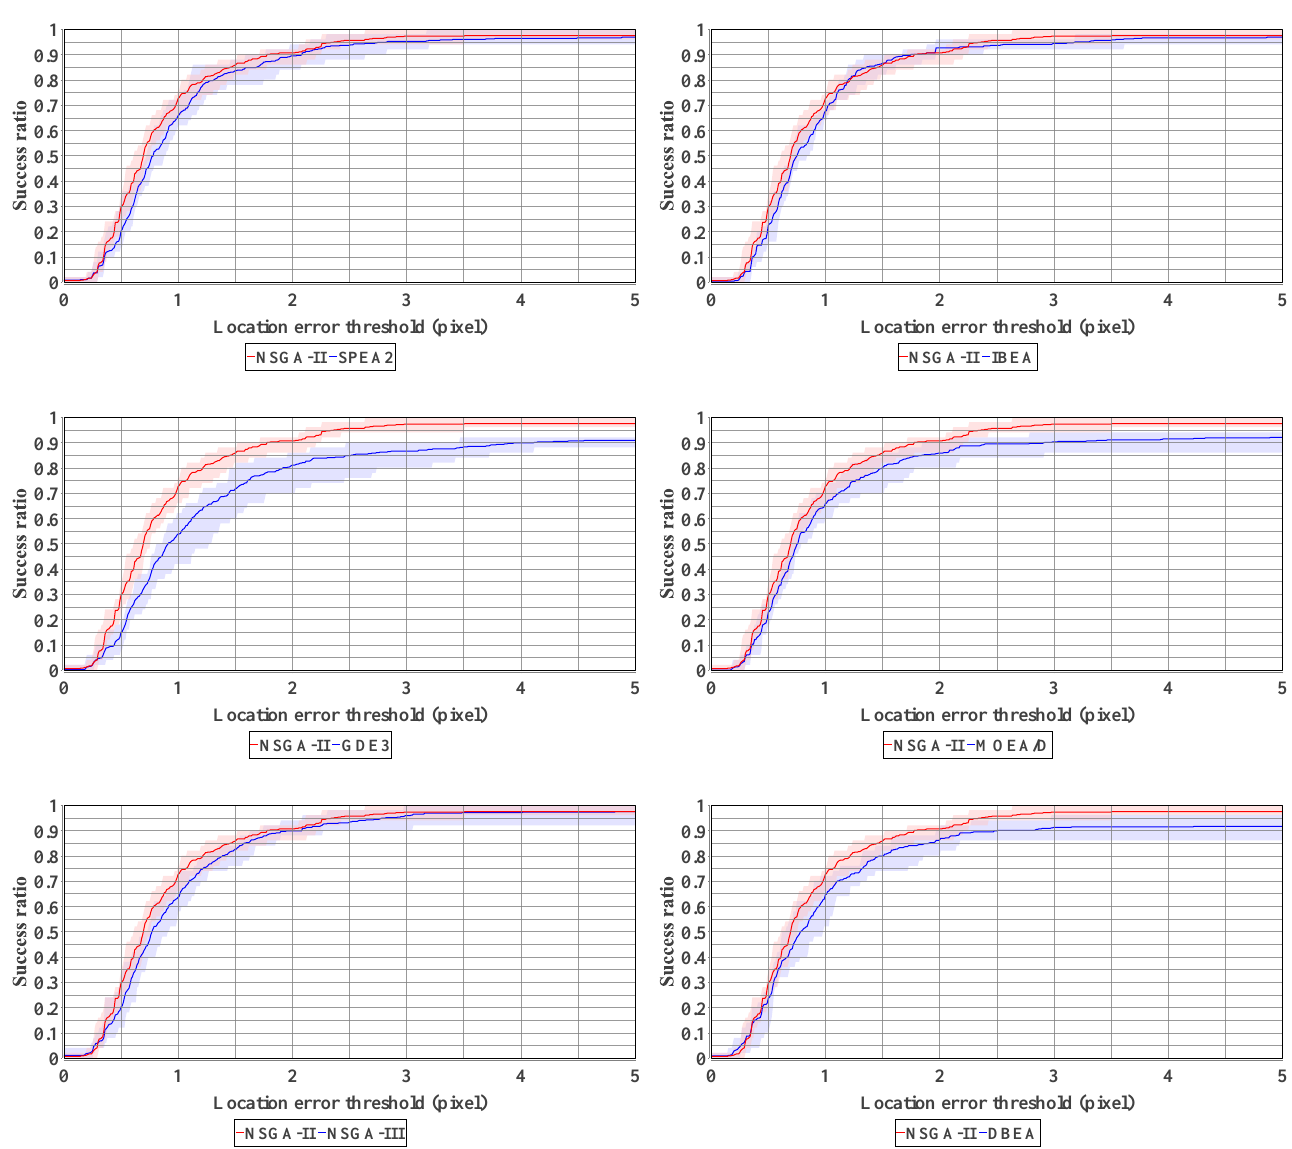
Figure 10. Comparative experiment. All test images are conducted 10 trials for the plots.